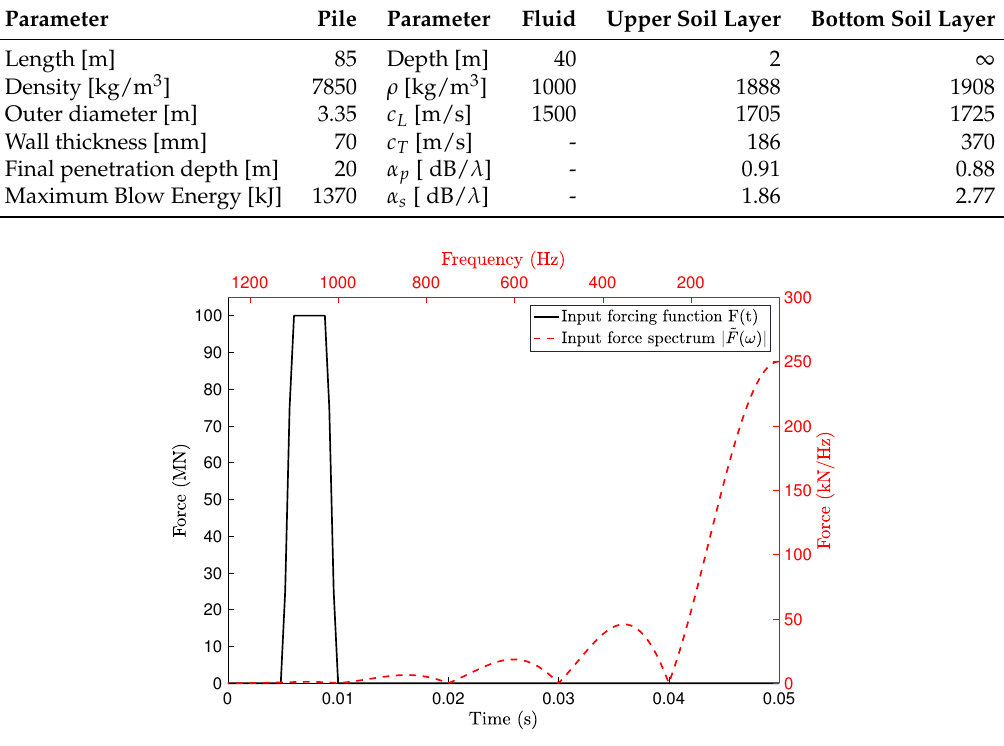
Table 2. Input parameters for the simulations at the BARD Offshore I offshore wind farm.